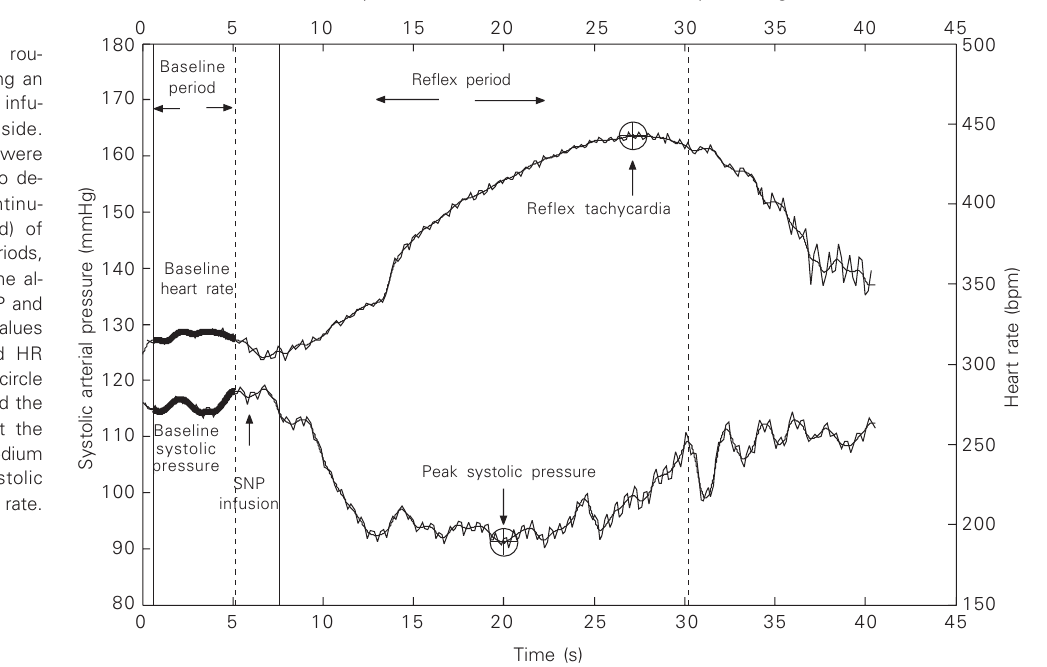
Figure 2. Example of the rou- tine graphic interface during an experiment with a bolus infu- sion of sodium nitroprusside. SBP and HR time series were presented to the user who de- fined the beginning (continu- ous) and the end (dotted) of the baseline and reflex periods, limited by vertical lines. The al- gorithm calculated the SBP and HR for baseline average values (thick line), the SBP and HR peak values (shown as a circle and cross on the lines), and the baroreflex index shown at the top of the figure. SNP = sodium nitroprusside; SBP = systolic blood pressure; HR = heart